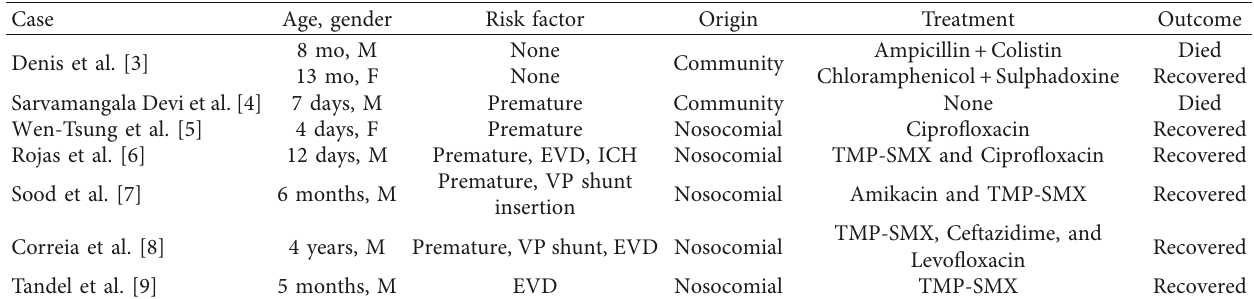
Table 2: Reported pediatric cases of S. maltophilia